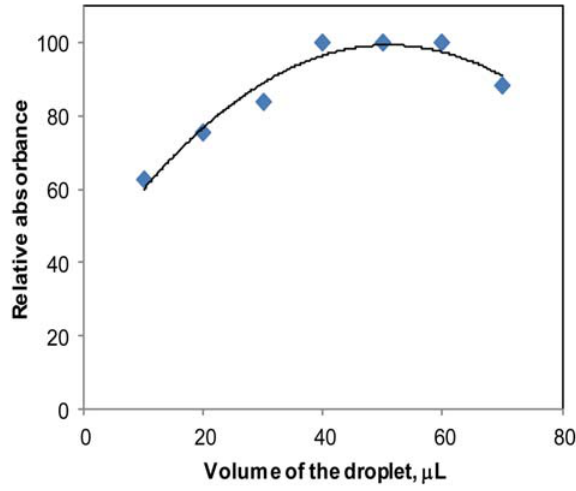
Figure 5. Effect of droplet volume on the relative absorbance (0.25 μg/L pH = 4), flow rate was 11 mL/min (GFAAS, droplet volume was diluted to 100 μL)